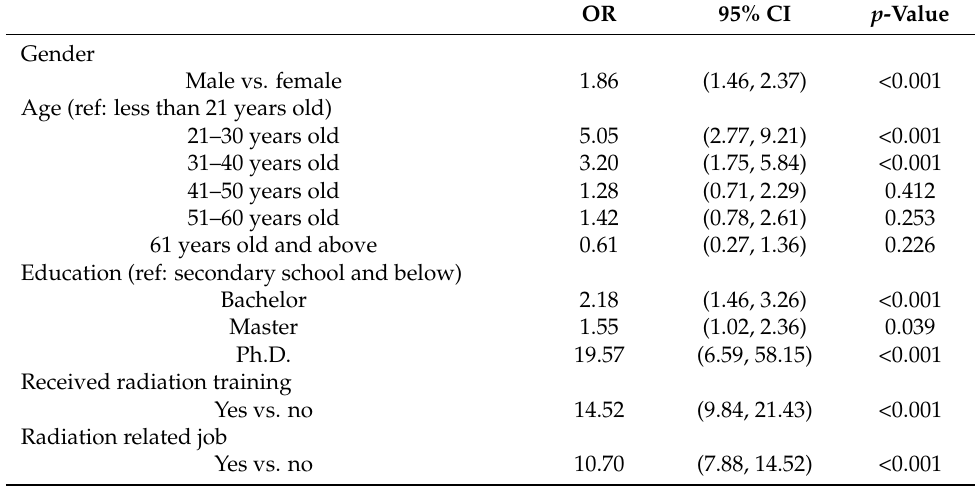
Table 2. Results of logistic regression analysis for individual factors.